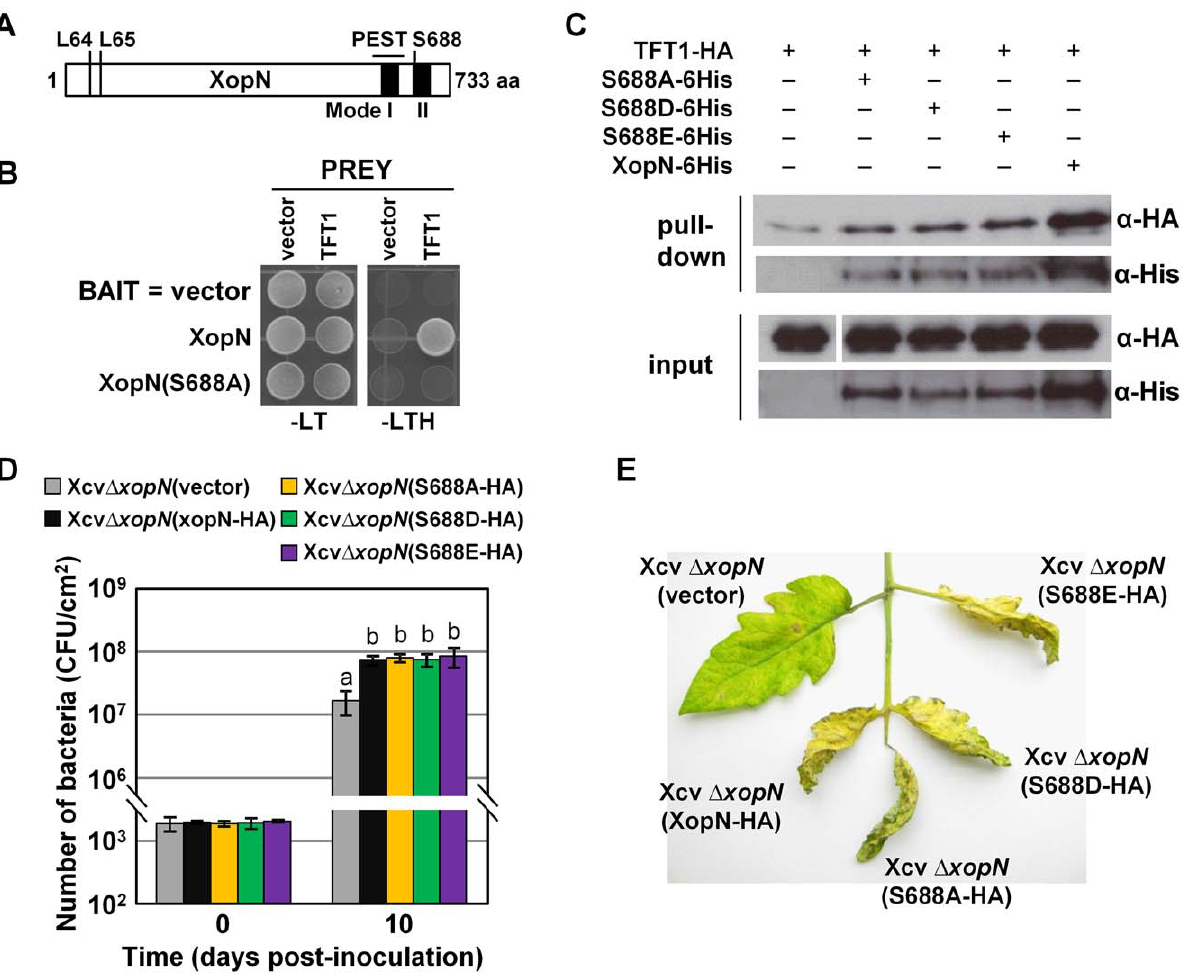
Figure 6. Serine 688 in XopN is required for TFT1 binding in yeast but not inplanta . ( A ) Schematic of putative 14-3-3 motifs in XopN protein. Black boxes represent regions for putative Mode I and II 14-3-3 binding motifs. Mode II site contains S688. PEST domain is underlined. N- terminal leucines (L64, L65) required for TARK1-binding are labeled. ( B ) XopN(S688A) mutant does not interact with TFT1 in yeast. Serine 688 in XopN was mutated to alanine. Yeast strain AH109 carrying pXDGATcy86(GAL4-DNA binding domain) containing XopN, and XopN(S688A) was transformed with the following PREY constructs: pGADT7(GAL4 activation domain) alone (Vector) or pGADT7 containing TFT1. Strains were spotted on nonselective (SD-LT) and selective (SD-LTH) medium and then incubated at 30 u C for 3d. ( C ) XopN(S688A) and two phosphomimetic mutants, XopN(S688D) and XopN(S688E), interact with TFT1 in N. benthamiana . Leaves were hand-infiltrated with a suspension (8 6 10 8 CFU/mL total) of two A. tumefaciens strains expressing TFT1-HA and XopN-6His or XopN(S688A)-6His or XopN(688D)-6His or XopN(688E)-6His. After 48 h, protein was extracted, purified by Ni + affinity chromatography, and analyzed by protein gel blot analysis using anti-His and anti-HA sera. Expected protein MW: XopN-6His, S688A-6xHis, S688D-6His, and S688E-6His=78.7 kDa; TFT1-HA=29.3 kDa. + , protein expressed; 2 , vector control. ( D ) Growth of Xcv D xopN (vector), Xcv D xopN (XopN-HA), Xcv D xopN (XopN(S688A)-HA), Xcv D xopN (XopN(S688D)-HA, or Xcv D xopN (XopN(S688E)-HA in susceptible tomato VF36 leaves. Leaves were inoculated with a 1 6 10 5 CFU/mL suspension of bacteria. Number of bacteria in each leaf was quantified at 0 and 10 DPI. Data points represent mean CFU/cm 2 6 SD of four plants. Different letters at day 10 indicate statistically significant (one-way analysis of variance and Tukey’s HSD test, P , 0.05) differences between the samples. Vector=pVSP61. ( E ) Phenotype of tomato leaves inoculated with the strains described in ( D ). Leaves were photographed at 12 DPI. Analysis was repeated two times.